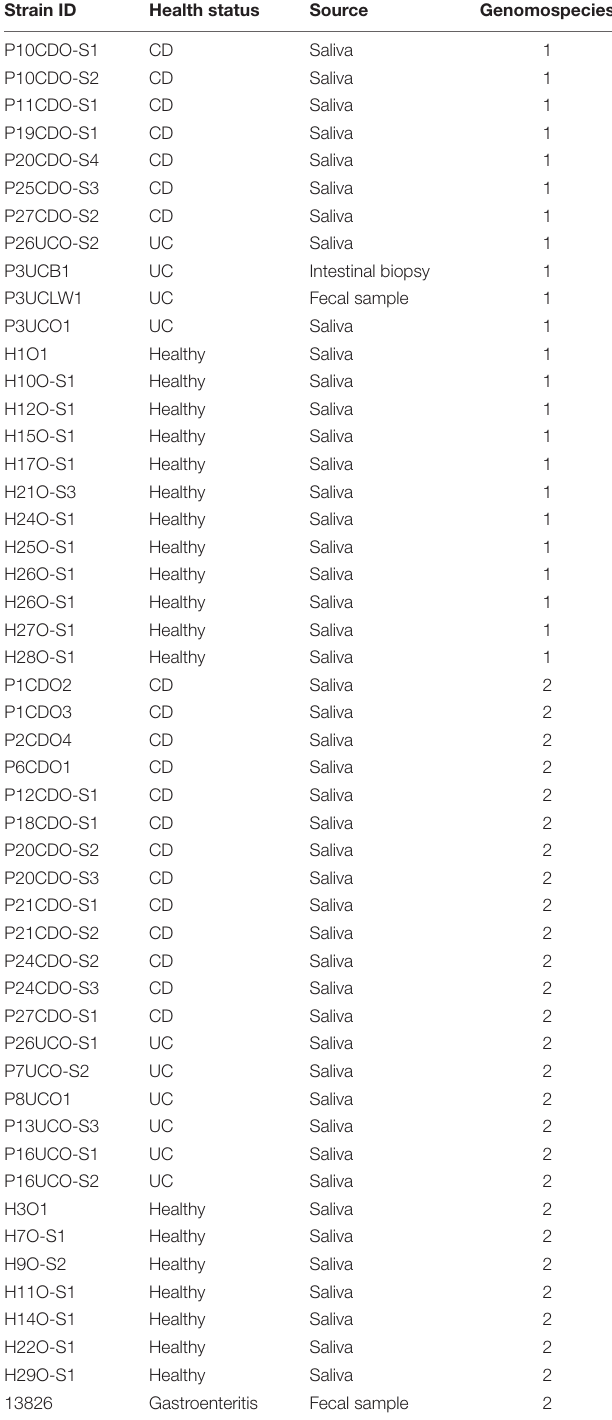
TABLE 1 | Bacterial strains used in this